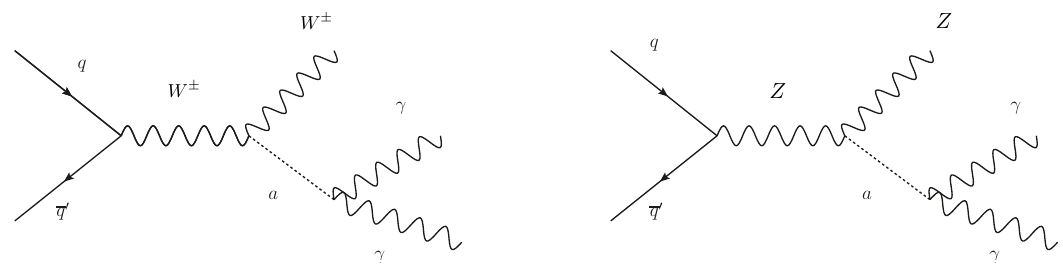
Figure 1 . Feynman diagrams of ALP-strahlung production processes pp → W ± a and pp → Za with ( a → γγ ) at the